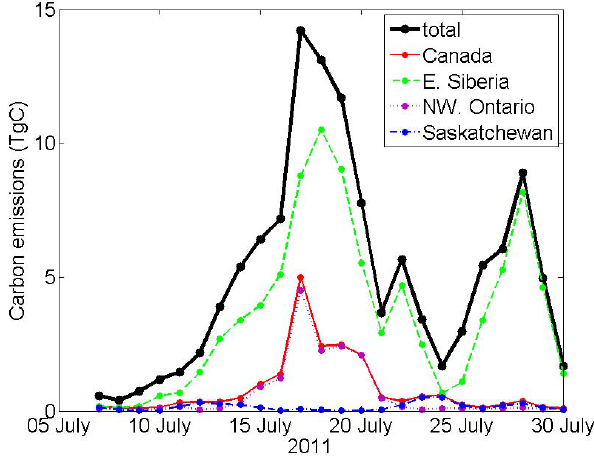
Fig. 4. Daily distribution of carbon emissions from the FLAMBE inventory based on fire information from MODIS and GOES. The traces show the daily total carbon emitted from all boreal fire regions ( ≥ 50 ◦ N, thick black line), for all of Canada (50 ◦ – 75 ◦ N, 170 ◦ –50 ◦ W, thin red line), northwestern Ontario (50 ◦ – 55 ◦ N, 95 ◦ –80 ◦ W, dotted purple line), Saskatchewan (55 ◦ –65 ◦ N, 120 ◦ –105 ◦ W, dot-dashed blue line), and eastern Siberia (50 ◦ – 75 ◦ N, 110 ◦ –179 ◦ E, dashed green